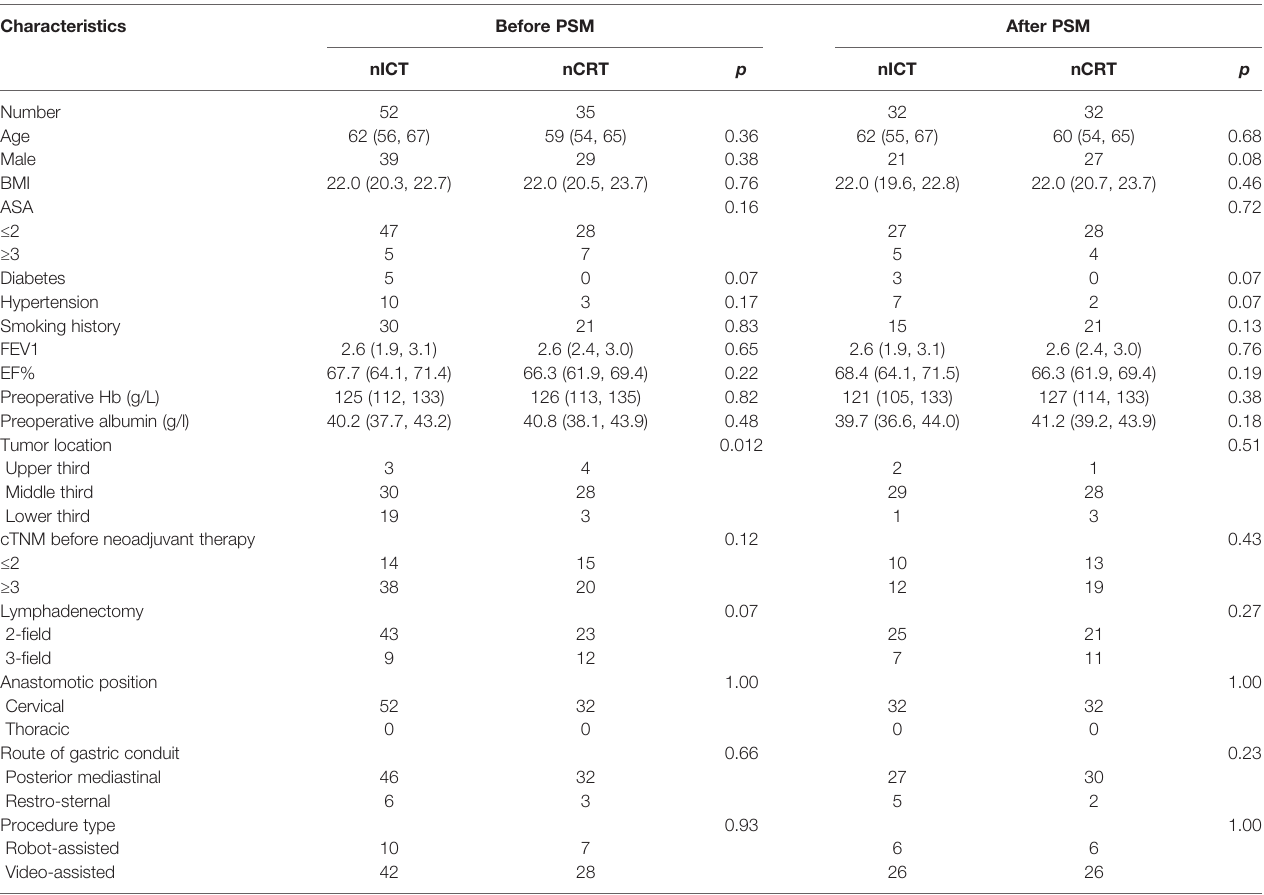
TABLE 1 | Baseline characteristic before and after propensity score matching.